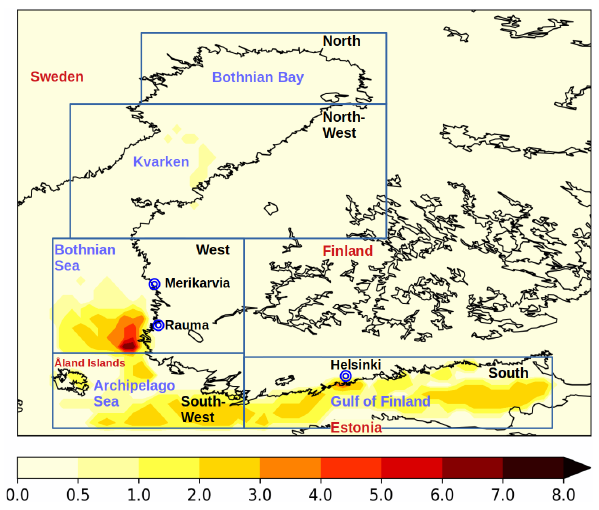
Figure 2. Total number of favorable days with a suitable wind di- rection (Table 1) to bring snowfall to the Finnish coast from 2000– 2010 based on RCA4 data. Different areas listed in Table 1 are shown with blue rectangles (south: S, south-west: SW, west: W, north-west: NW, north: N). Sea areas, countries and mentioned cities are also